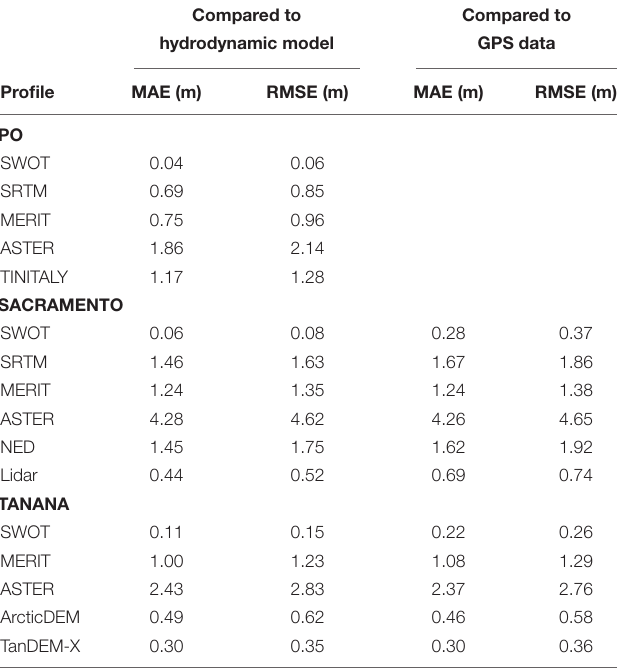
TABLE 3 | Error statistic comparison of simulated SWOT profiles and profiles extracted from existing DEMs. Compared to Compared to